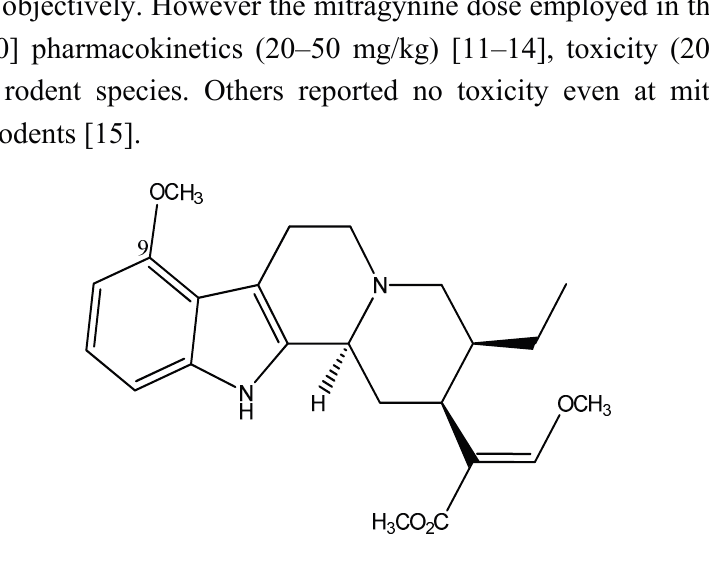
Figure 1. Chemical structure of mitragynine C 23 H 30 N 2 O 4